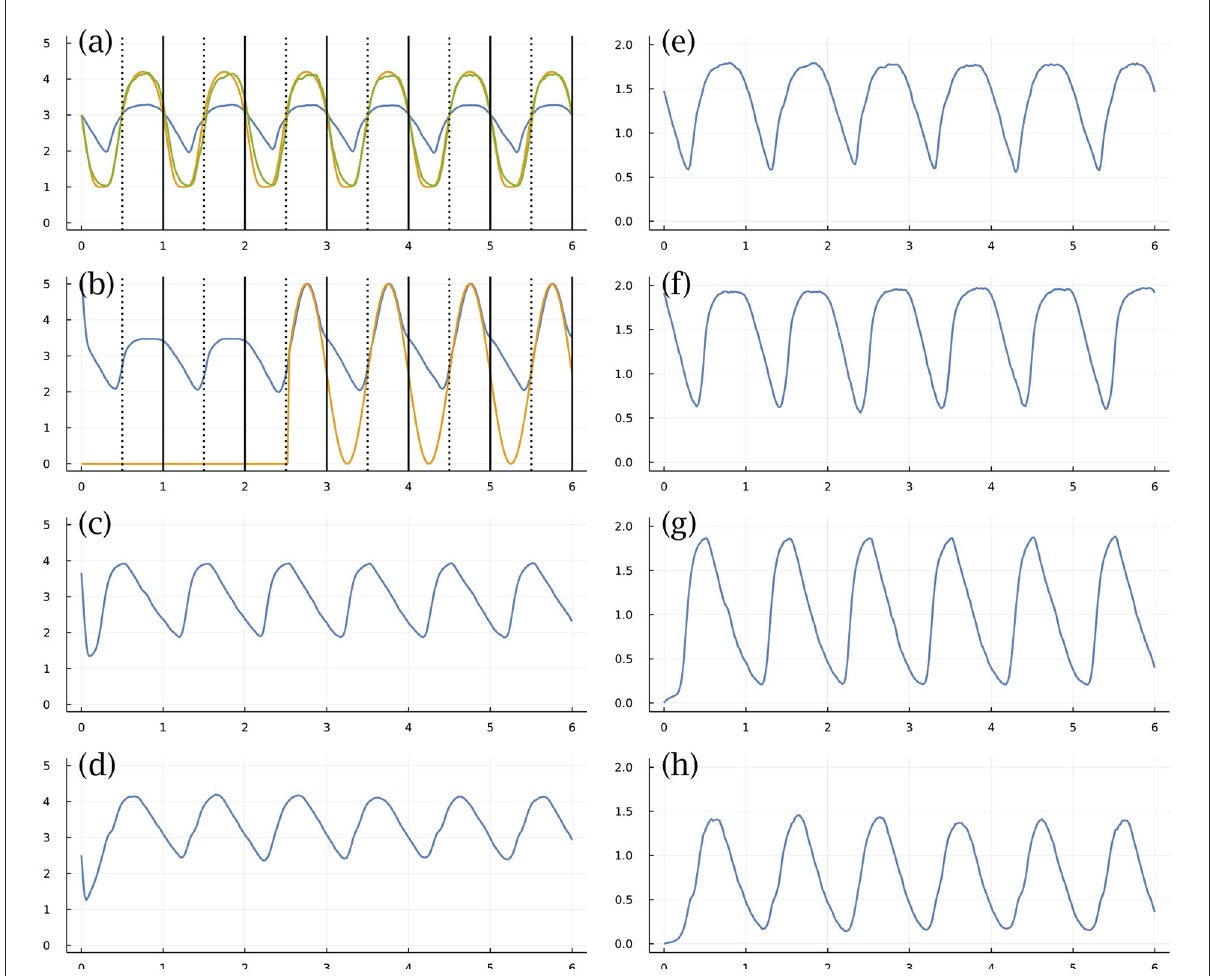
FIGURE3 Circadian dynamics with stochastic fluctuations and random daylight signal. (a–d) Abundance of TFs on log10(1 + y ) scale for y molecules per cell. (e–h) Abundance of mRNAs for associated TFs. See text for explanation. From Figure 1 of Frank